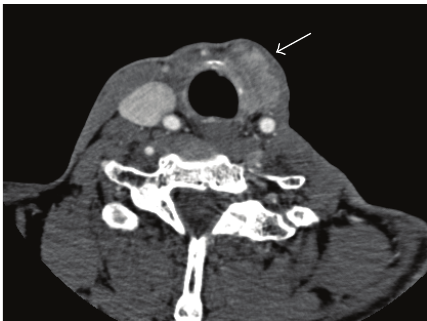
Figure 1: CT scan showing cricoid cartilage invasion by thyroid carcinoma (arrow).